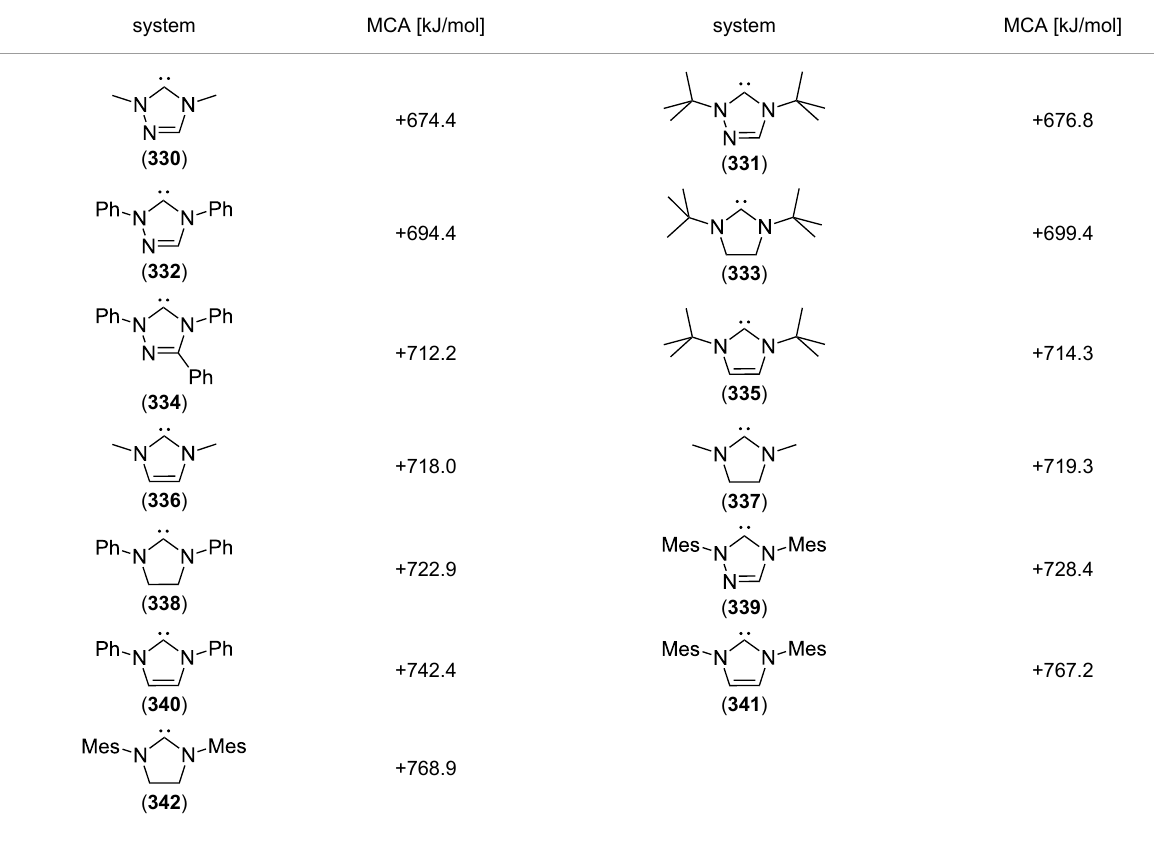
Table 8: MCA values of carbenes, ordered by increasing MCA values